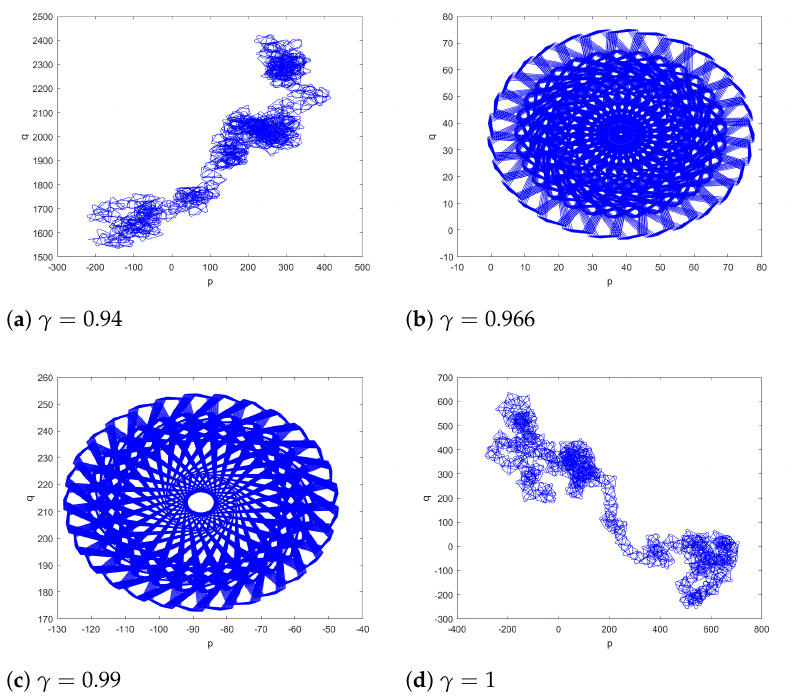
Figure 8. The p – q trajectories of the 0 − 1 test of the fractional discrete SIR epidemic model (11) with commensurate orders ( γ 1 = γ 2